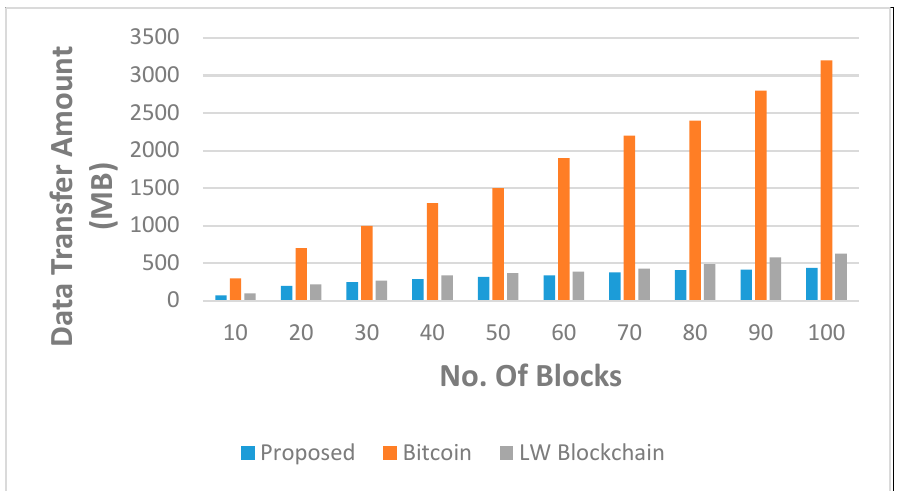
Figure 6. The count of blocks grows larger against the aggregate of data moved via bitcoin, LW blockchain, and our proposed secure blockchain architecture.